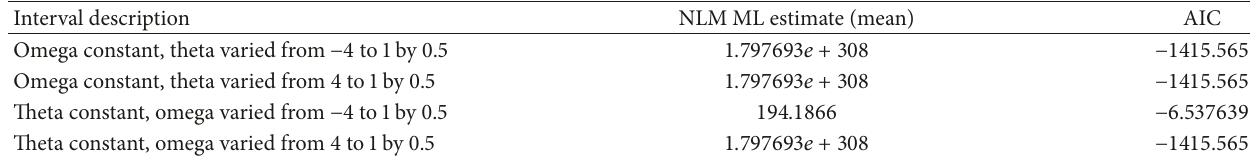
Table 5: Summary of results for lambda = 0.5, 𝑛 = 10 𝑖 , 𝑖 = 3